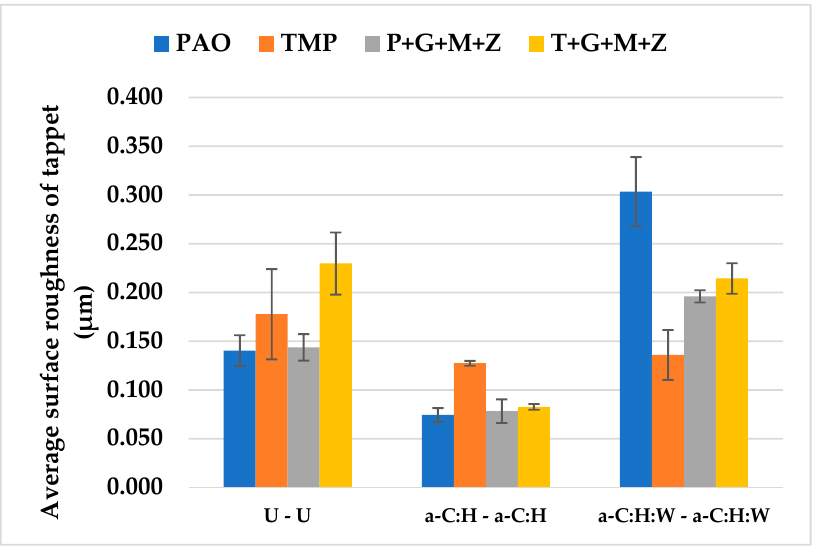
Figure 20. Average surface roughness of uncoated and DLC-coated tappets after cylinder head testing under various conditions in combination with uncoated and DLC-coated camlobes in the presence of PAO-based and TMP-based lubricants.